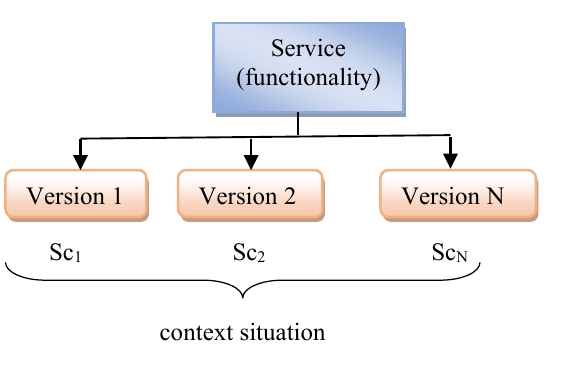
Figure 6 . Service with its versions